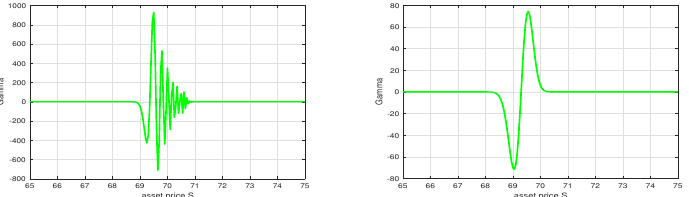
Figure 15. Plots of Gamma obtained with the MADE scheme ( left ) and the MMADE scheme ( right ), with parameter values r = 0.01, σ = 0.001, a = − 1250, T = 1, U = 70, K = 50, L = 30, S max = 140, ∆ S = 0.05, ∆ t = 10 − 3